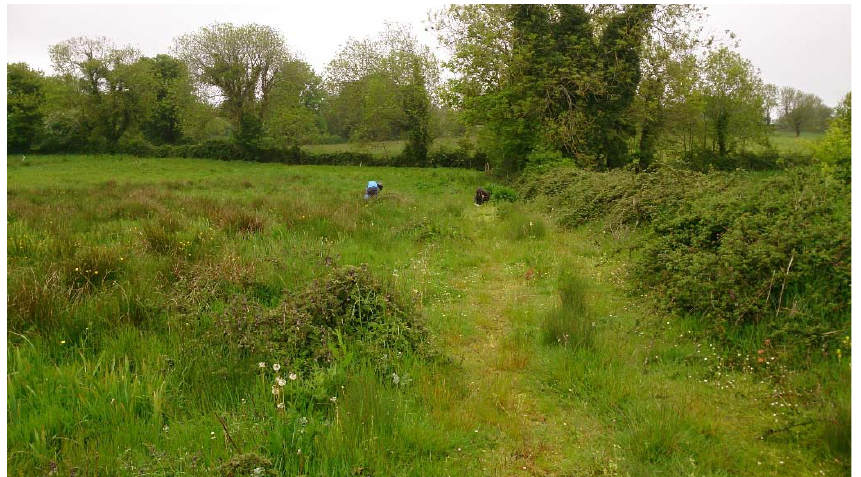
Figure A4. Site PK, looking west. The soil in the rough ground in the foreground is high in selenium, but the soils in the field up the slight slope in the background are low in selenium.